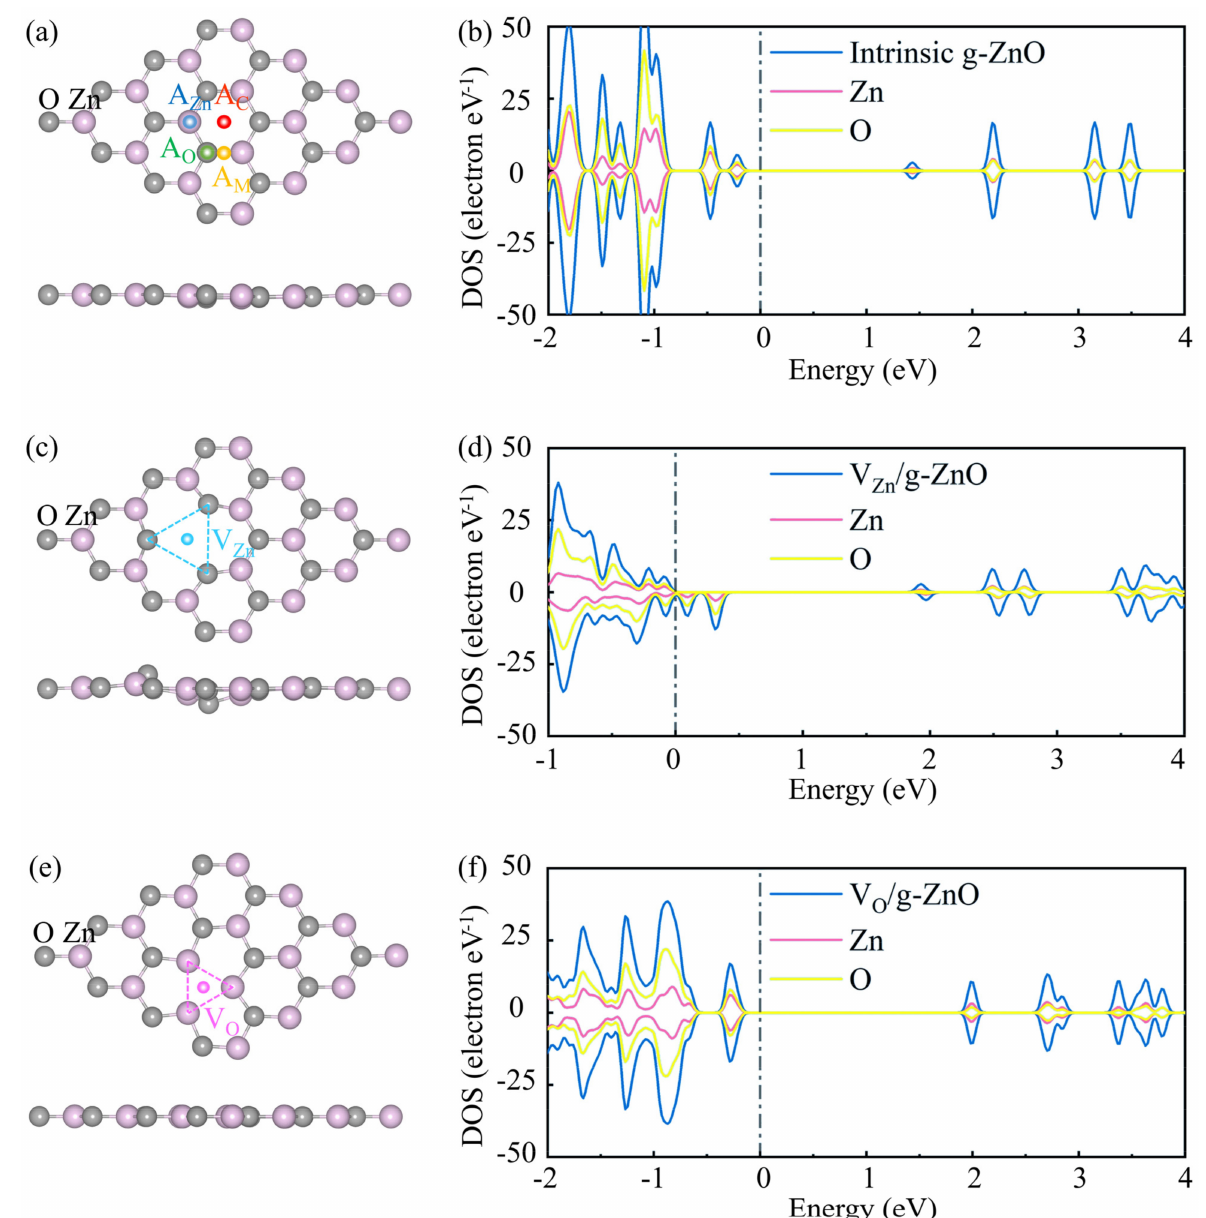
Figure 1. ( a ) The crystal structure and ( b ) DOS of intrinsic g − ZnO. A Zn is above the Zn atom. ( c ) The crystal structure and ( d ) the DOS of Zinc vacancy g − ZnO (V Zn /g − ZnO), and ( e ) The crystal structure and ( f ) the DOS of Oxygen vacancy g − ZnO (V O /g − ZnO). A O is upper the O atom, A M is upper the bond of Zn-O, and A C is upper the center of the hexagonal structure. V Zn is upper the Zn vacancy, and V O is above the O vacancy. The pink spheres represent Zn atoms, and the grey spheres represent O atoms. The Fermi level is shifted to 0